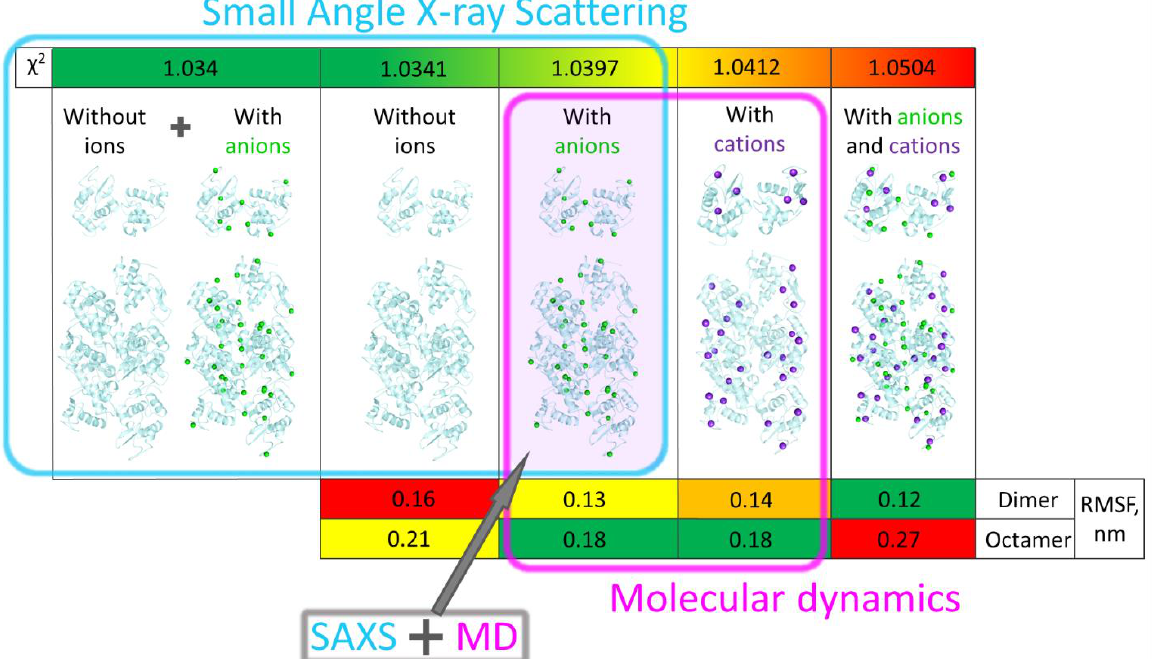
Table 3 . RMSF of C α atoms of lysozyme dimer and octamer for the cases with the different occu- pancy of cations (Na + ) and anions (Cl − ).